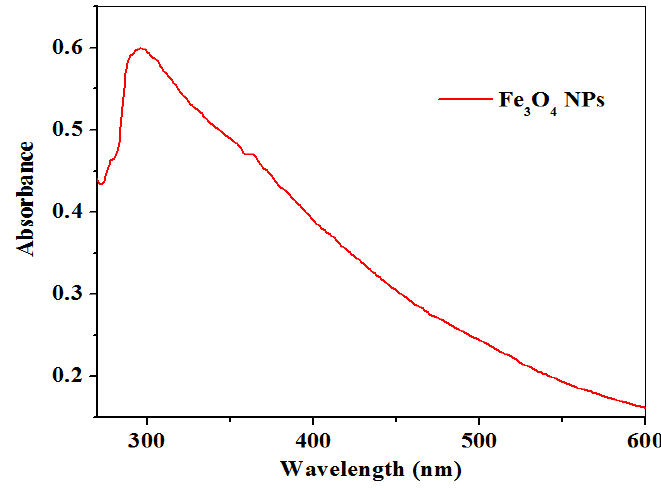
Figure 1. UV–Vis spectra of Fe 3 O 4 NPs using L. serica leaf extract.